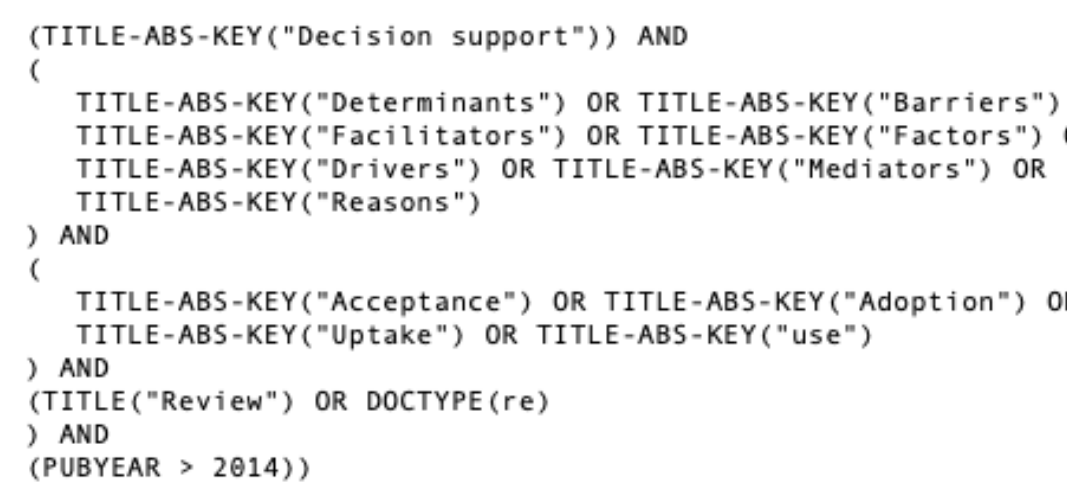
Figure 2. Search strategy used in